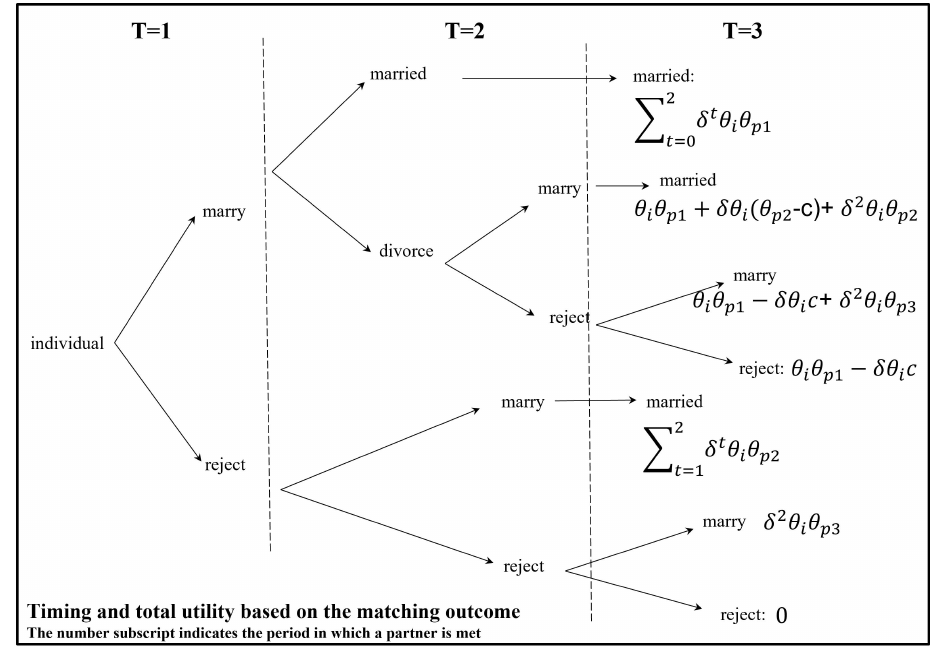
Figure 2. Timing and total